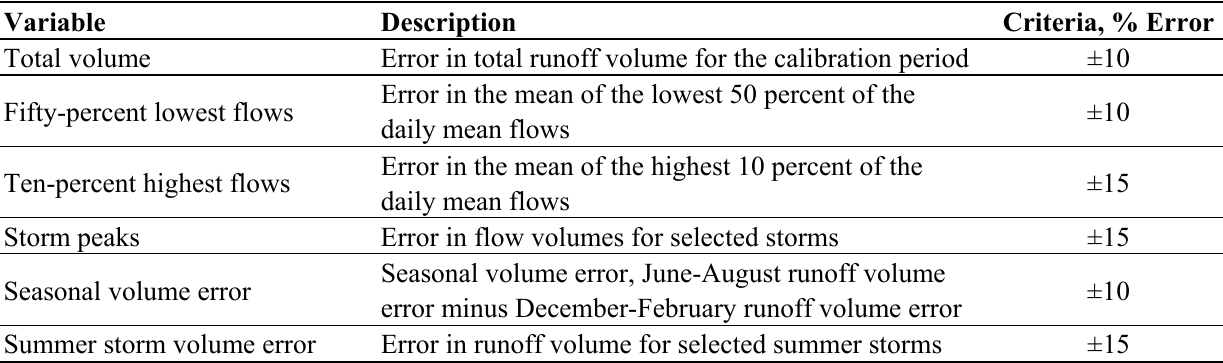
Table 1. HSPEXP model performance criteria for hydrologic calibration of HSPF (revised from Kim et al. [5]).